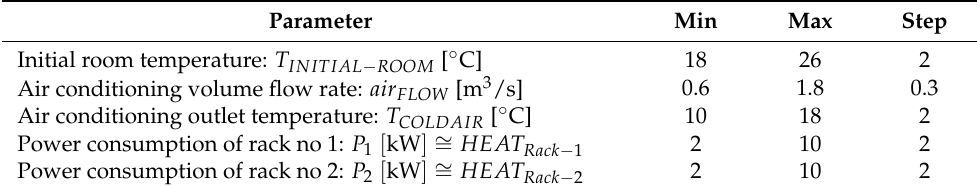
Figure 8. The CFD model of the server room implemented in OpenFoam. Table 1. List of parameters variation for simulation scenarios.